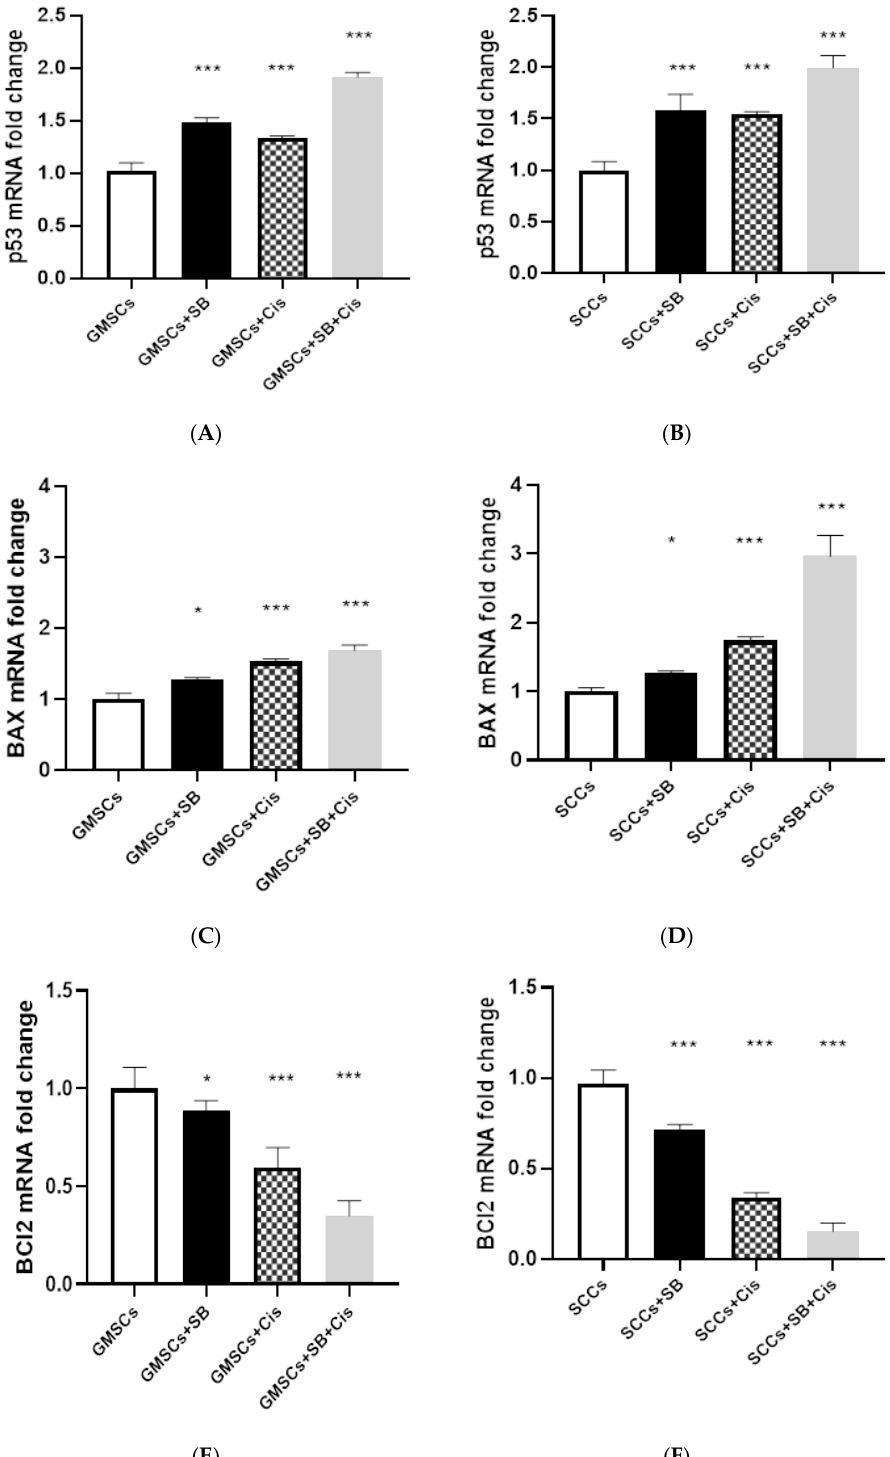
Figure 5. E ff ect of Schi ff base complex (SB) treatment and cisplatin (Cis) on ( A ) p53 mRNA level on gingival mesenchymal stem cells (GMSCs); ( B ) p53 mRNA level on Oral squamous cell carcinoma (SCC); ( C ) BAX mRNA level on GMSCs; ( D ) BAX mRNA level on SCC; ( E ) BCl2 mRNA level on GMSCs; ( F ) BCl2 mRNA level on SCC. * p < 0.05; *** p <